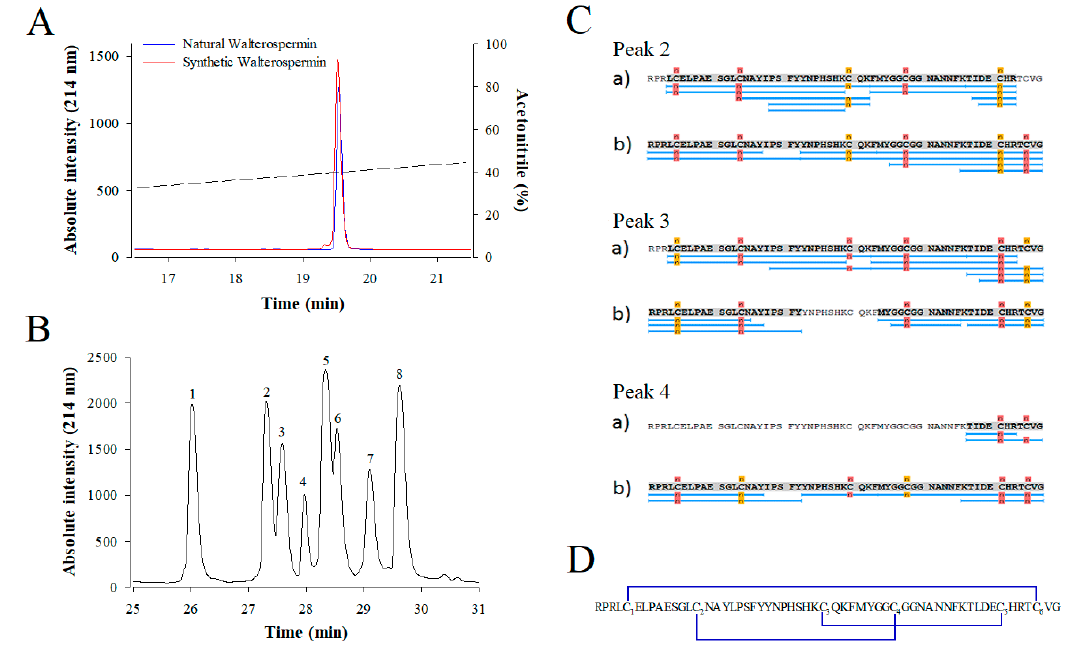
Figure 9. Coelution of synthetic and natural walterospermin and disulfide bridge assignment. ( A ) Coelution experiment. Natural (blue) and synthetic (red) walterospermin elution profiles are shown after separation on analytical RP-HPLC (AdvanceBio Peptide Map 2.1 × 250 mm, 2.7 µm from Agilent Technologies). The ACN gradient is shown as dashed line. ( B ) HPLC-UV (214 nm) trace of walterospermin after partial reduction and alkylation. Peak 1: folded walterospermin; peak 2-4: walterospermin with one reduced/alkylated bridge; peak 5–7: walterospermin with two reduced/alkylated bridge; peak 8: fully reduced/alkylated peptides. ( C ) Sequence coverage obtained by LC-ESI-MS(/MS) analyses of (a) tryptic and (b) chymotryptic digests of intermediates 2-4 containing N-propyl-maleimide (NPM) and N-ethyl-maleimide (NEM). Blue lines indicate peptide sequences analyzed. Yellow and red labels indicate NPM and NEM derivates, respectively. ( D ) Disulfide bridge arrangement of synthetic walterospermin. Cysteines were numbered by their order of appearance in the sequence. Underlined sequence corresponds to the active site of Kunitz-type protease inhibitors.